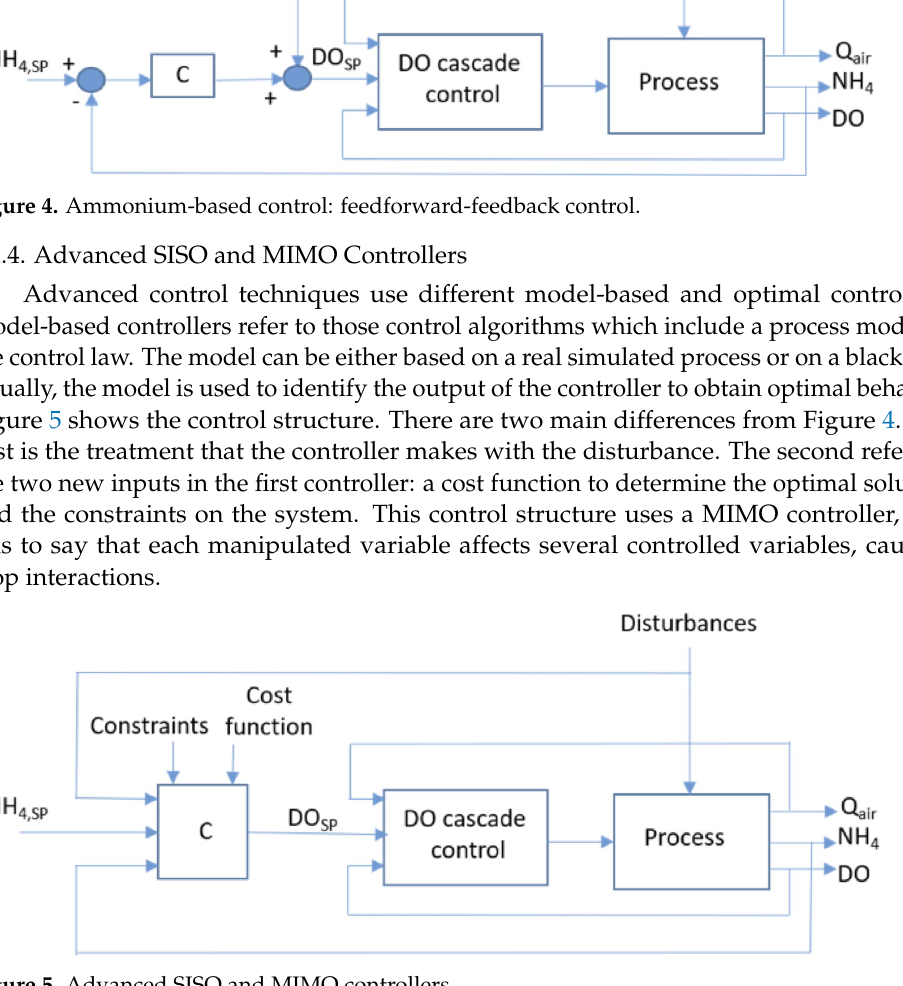
Figure 5. Advanced SISO and MIMO